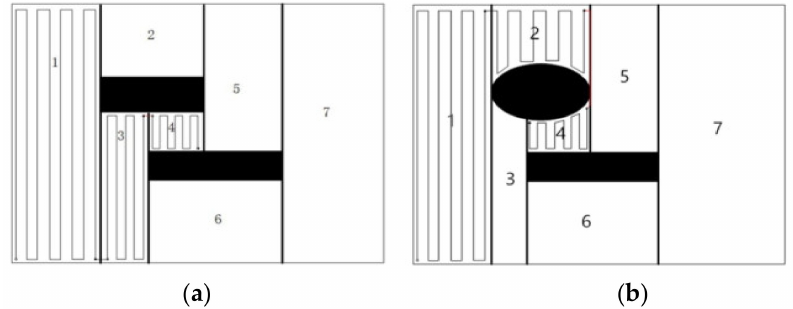
Figure 4. Adjacent region. ( a ) Right adjacent region. ( b ) Left adjacent region. Case 2: The adjacent region is to the right of the last traversed region, as shown in Figure 4b. Region 4 has been traversed, and it is judged that the adjacent region meets Formula (7b), and the adjacent region is obtained as region 3. Then the next movement region is region 3.